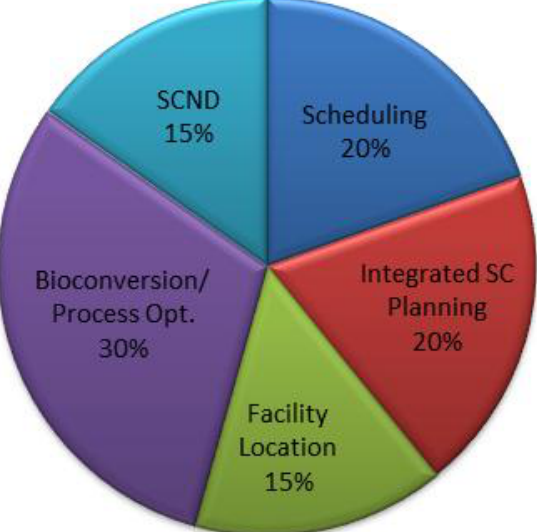
Figure 4. Publications distribution by